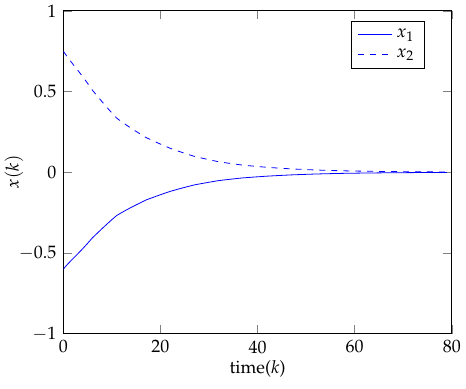
Figure 3. The state trajectory.